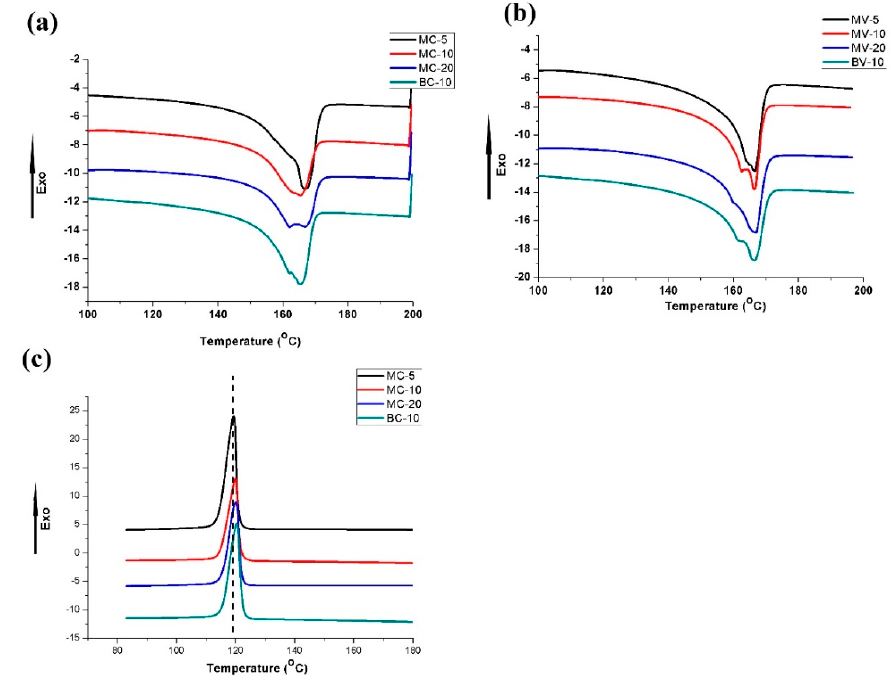
Figure 7. Differential scanning calorimetry (DSC) curves: heating processes of samples prepared by ( a ) CIM and ( b ) MFVIM; ( c ) cooling